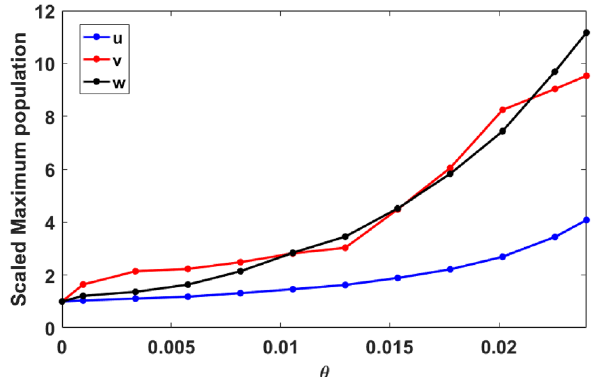
Figure 5. Global maximum of vegetation u max (blue), prey v max (red) and predator (black) populations,